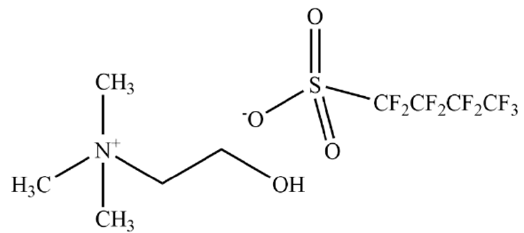
Figure 1. Chemical structure of cholinium perfluorobutanesulfonate, [N 1112(OH) ][C 4 F 9 SO 3